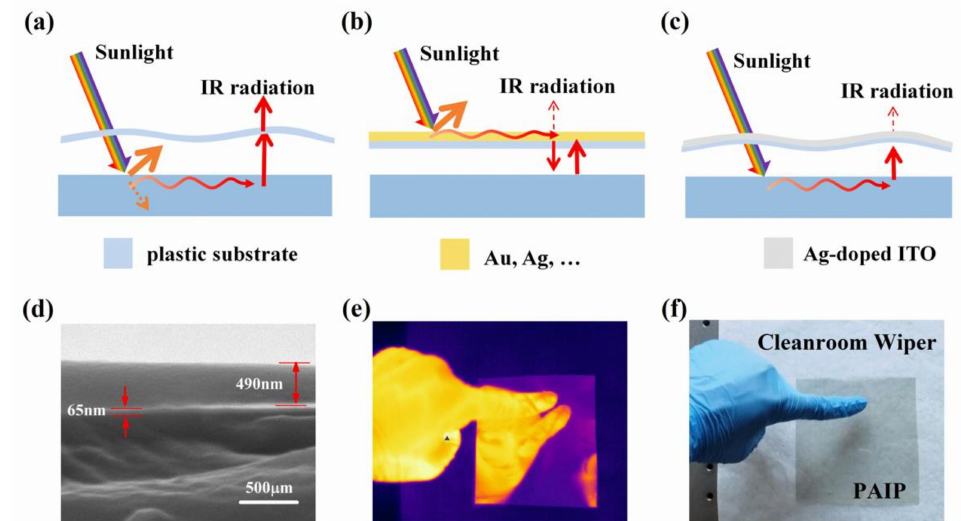
Figure 1. ( a ) Schematics illustration of object covered with normal transparent polymer thin film. ( b ) Object covered with metal. ( c ) Object covered with Ag-doped ITO thin film. ( d ) SEM photograph of the PET / Ag-doped ITO / PDMS (PAIP)sample’s cross section. ( e ) IR photography of PAIP sample to show the highly IR reflection. ( f ) Visible photography of sample to illustrate the